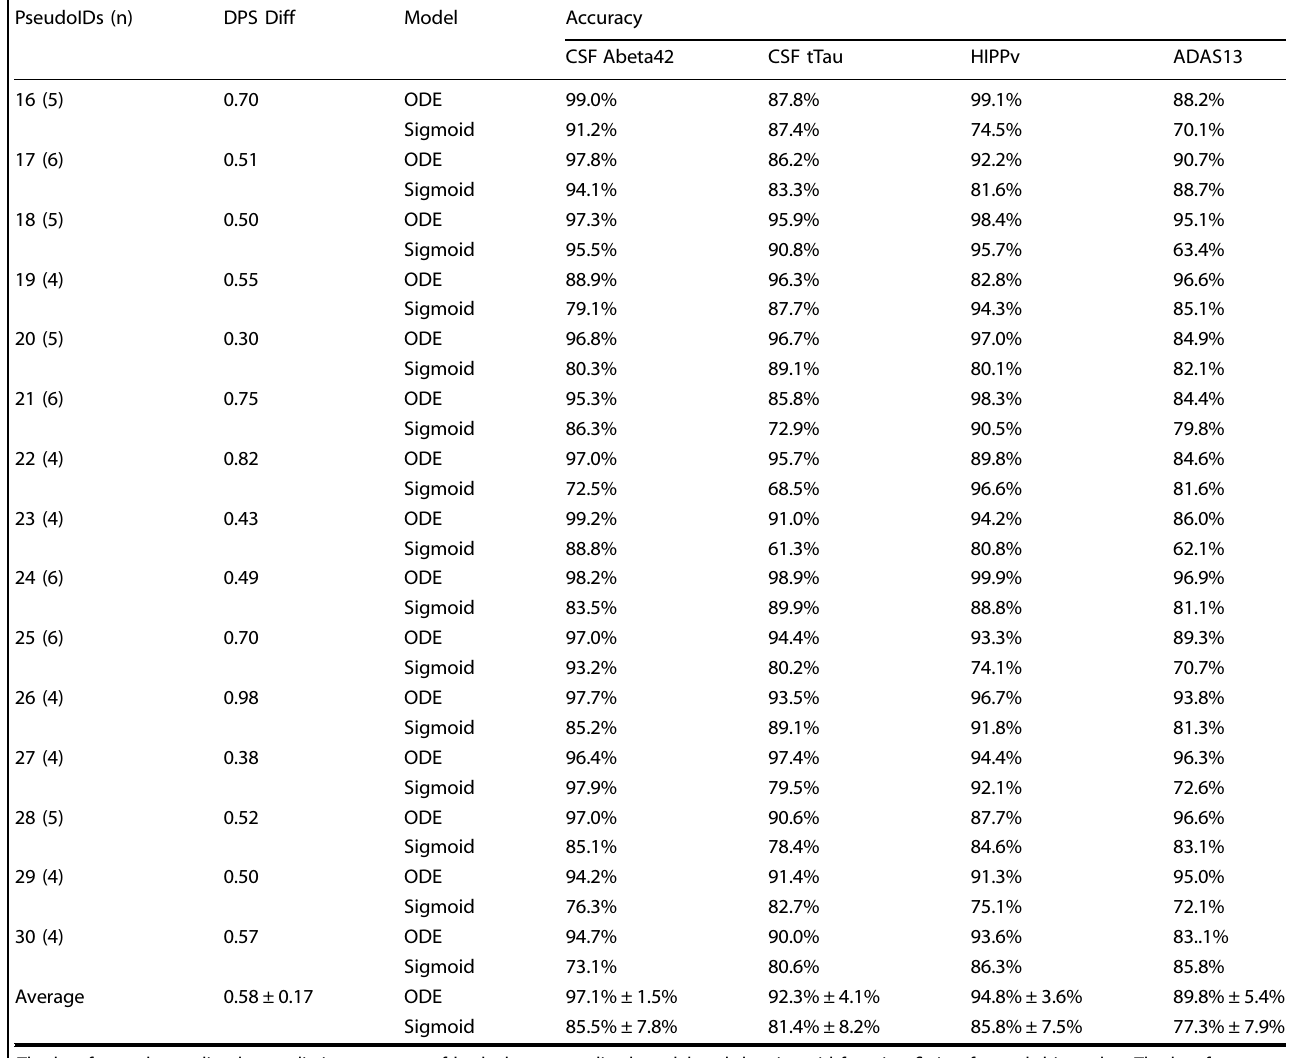
Table 3. The prediction accuracy summary for LMCI subjects using different longitudinal data points (shown in the fi rst column). PseudoIDs